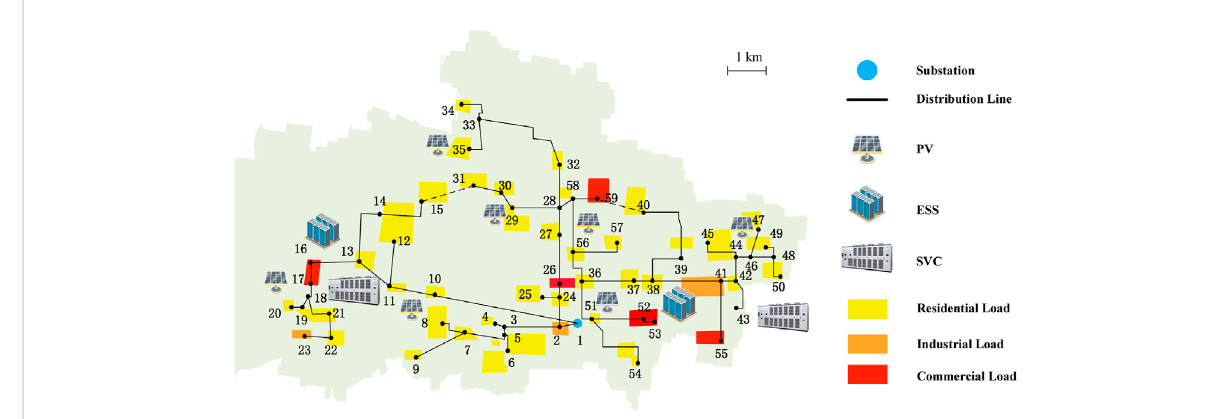
FIGURE 3 Testing the proposed model on the 59-bus rural distribution network.